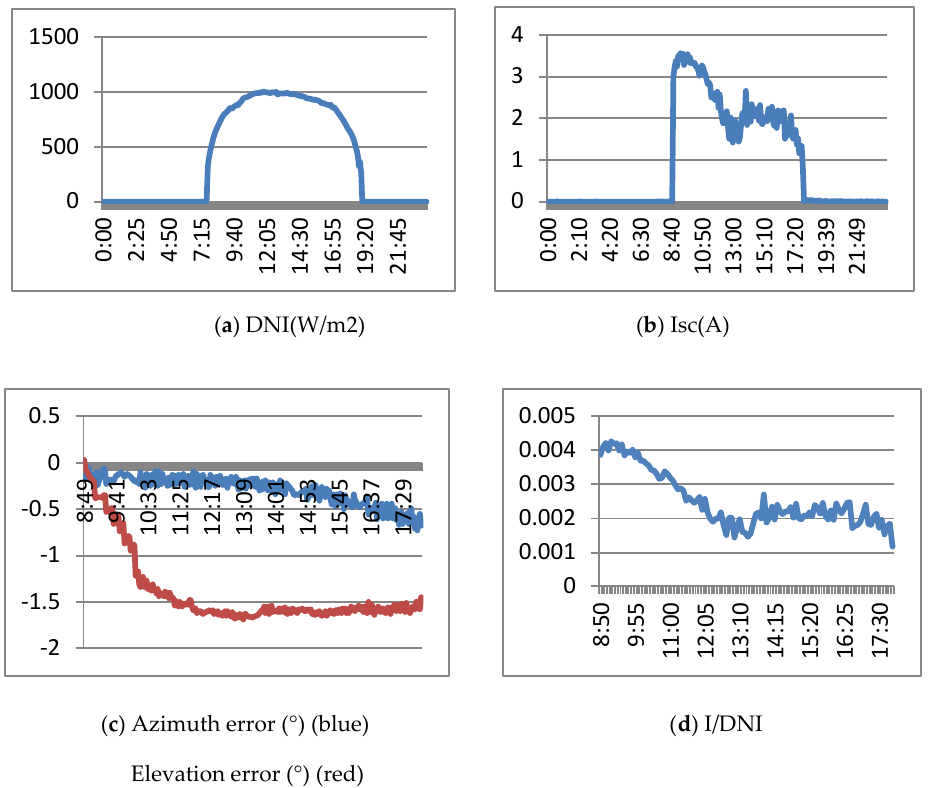
Figure 13. Results of the ephemeris controller. March 15, 2019.